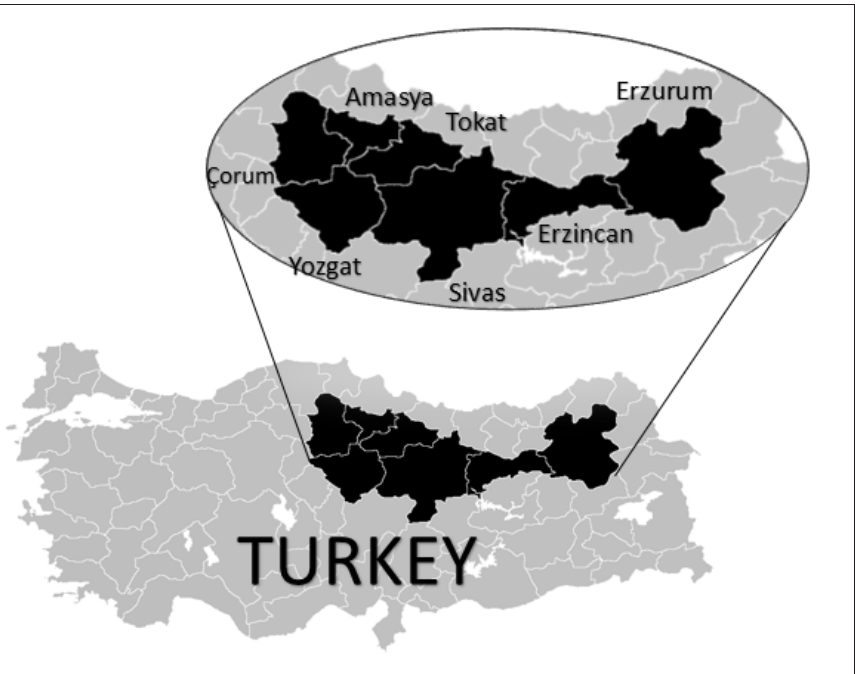
Figure 1. Region with the most observed cases of CCHF in Turkey